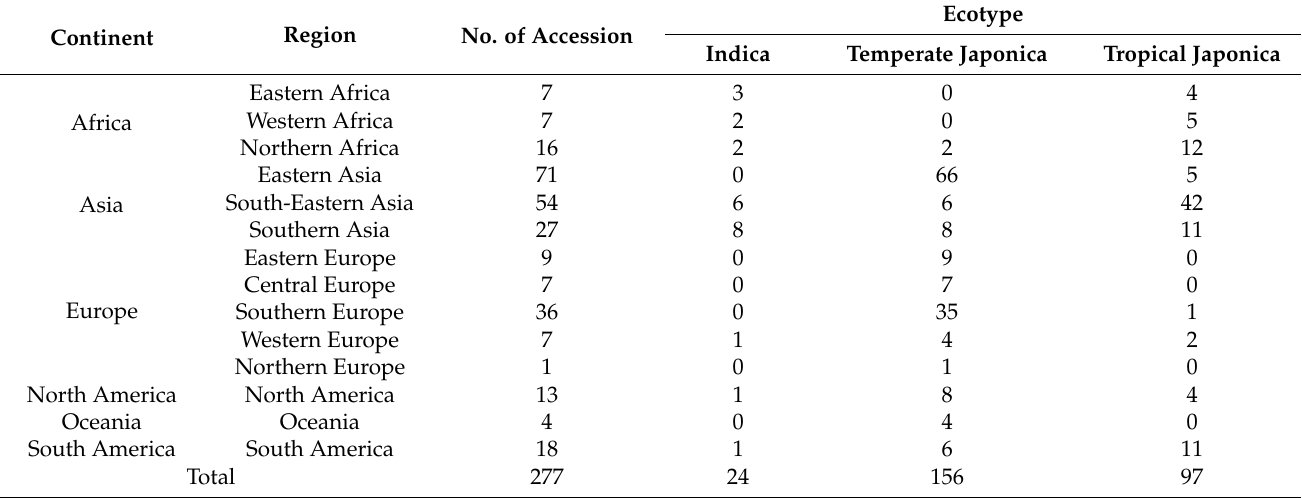
Table 2. The diverse rice panel used in this study.